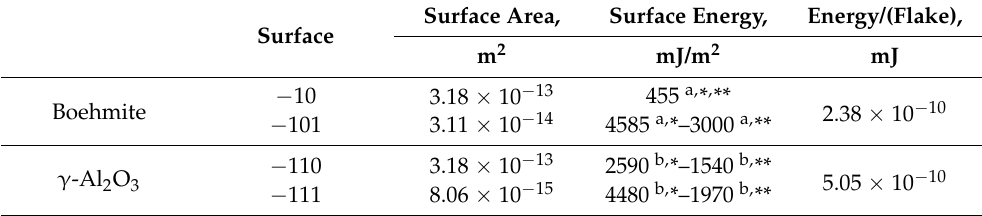
Table 4. Thermodynamics data. Surface Area, Surface Energy, Energy/(Flake), Surface m 2 mJ/m 2 mJ − Boehmite